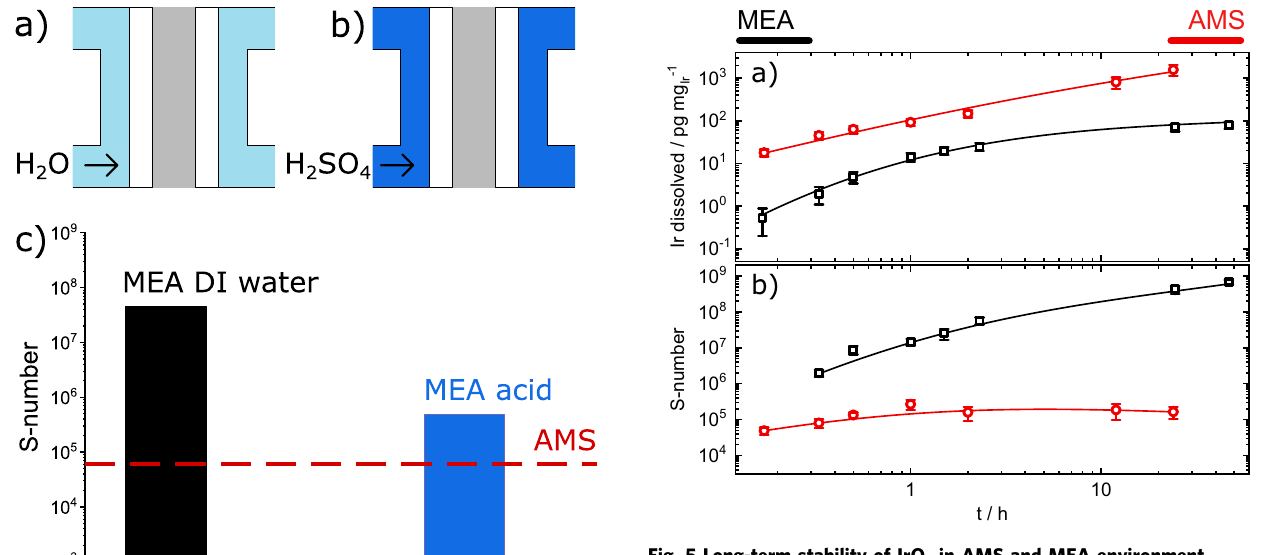
Fig. 5 Long-term stability of IrO x in AMS and MEA environment. a Loading-normalized total dissolved iridium amount at current densities of 0.2 A mg Ir − 1 and 2 A mg Ir − 1 in AMS and MEA, respectively; b S-numbers calculated from the amounts of dissolved iridium. Lines displayed for ease of interpretation. Error bars were calculated as the standard deviation of at least three independent measurements. Source data are provided in the source data fi le.